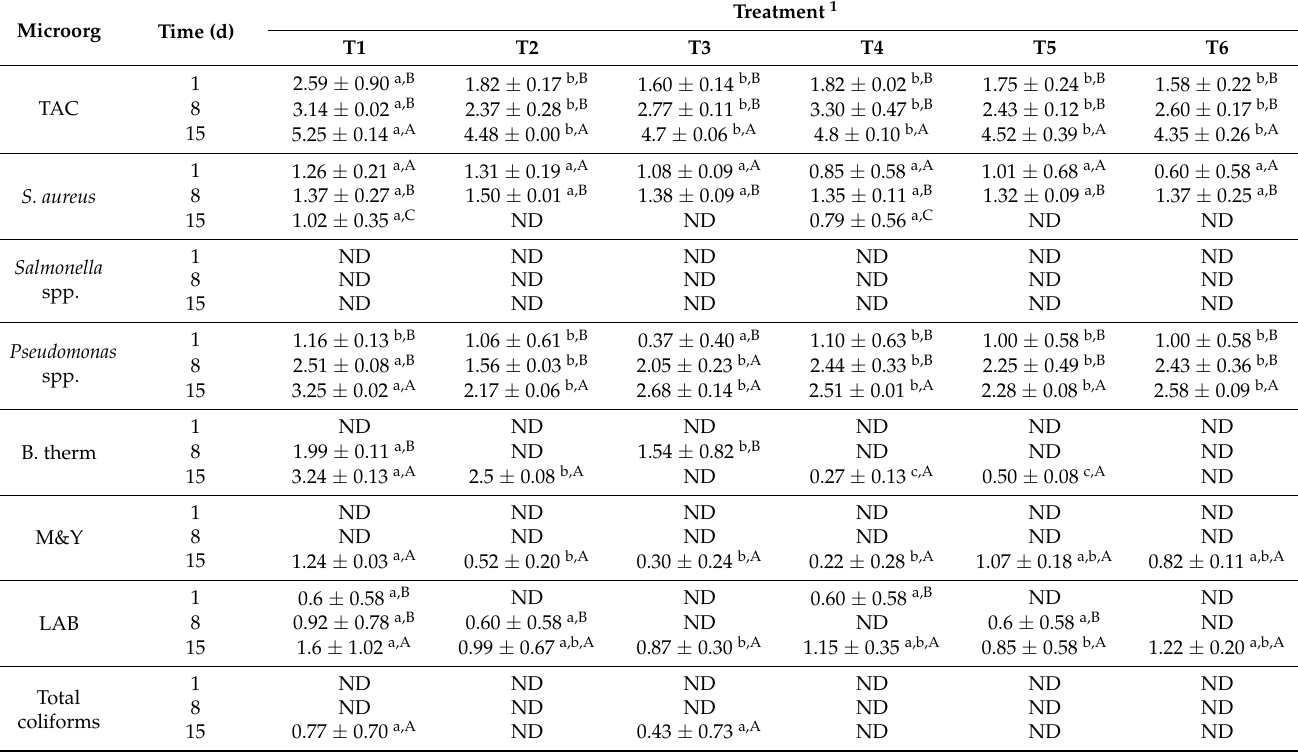
Table 3. Microbial quality (log 10 CFU/g, mean ± standard deviation) of beef hamburgers added to rosemary ( Rosmarinus officinalis ) and garlic ( Allium sativum ) essential oils and chipotle pepper ( Capsicum annum ) over